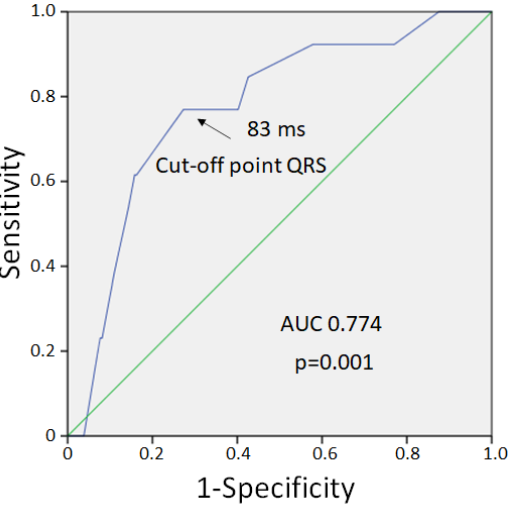
Figure 3. ROC curve analysis of association between QRS duration and VF development.